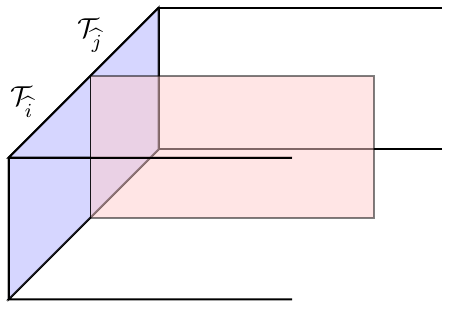
Figure 6 . The boundary of the bulk theory is denoted B [ T ] . The resulting theories T by walls. When we compose the filter defect in with the boundary, the new boundary becomes that of the bulk theory T // A . [1]